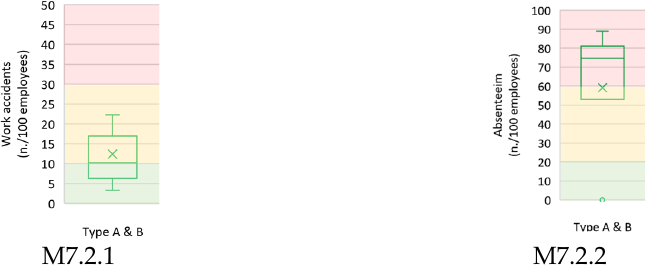
Figure 11. Results of the validation applied to the wastewater utilities: objective 7.